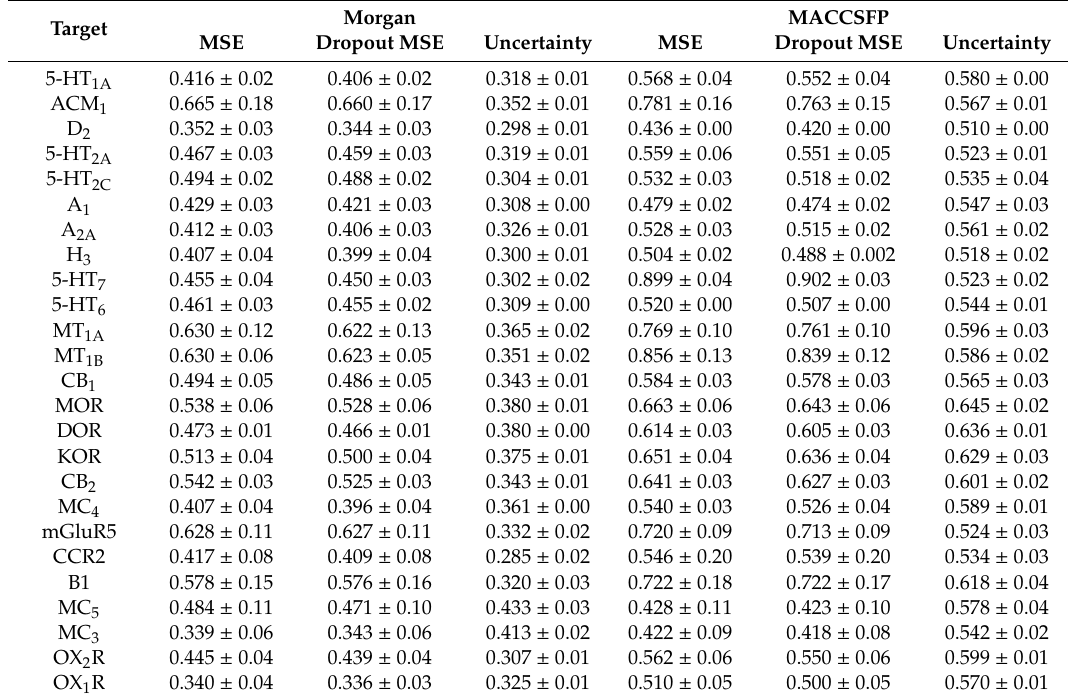
Table 1. Regression results obtained for random CV.